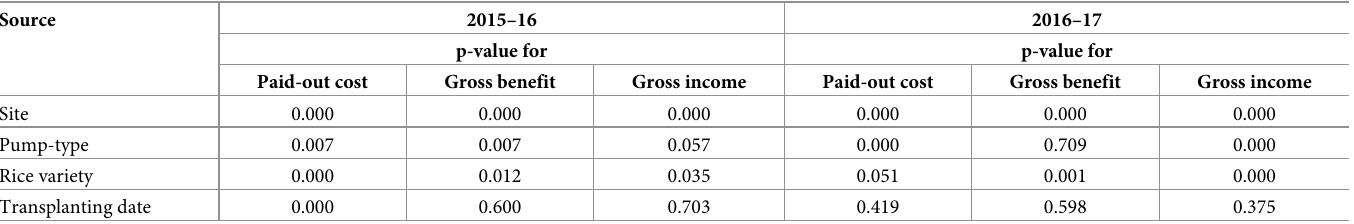
Table 6. Probability levels in the variance of total paid-out cost, gross benefit and gross income among the sites, pump-types, rice varieties, and transplanting dates.